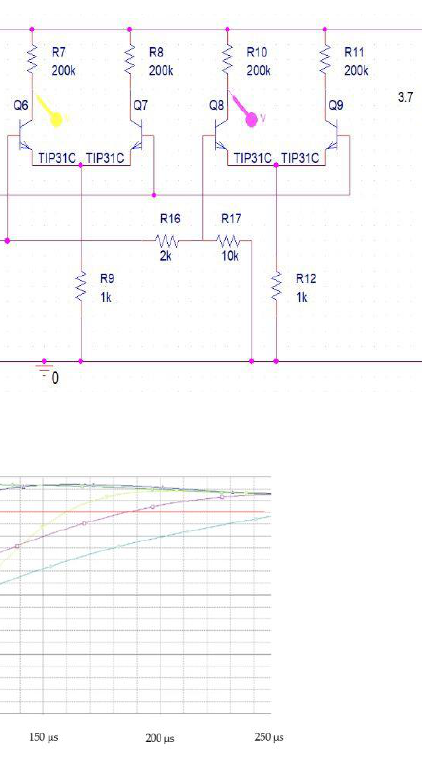
Figure 12. Simulation Output.